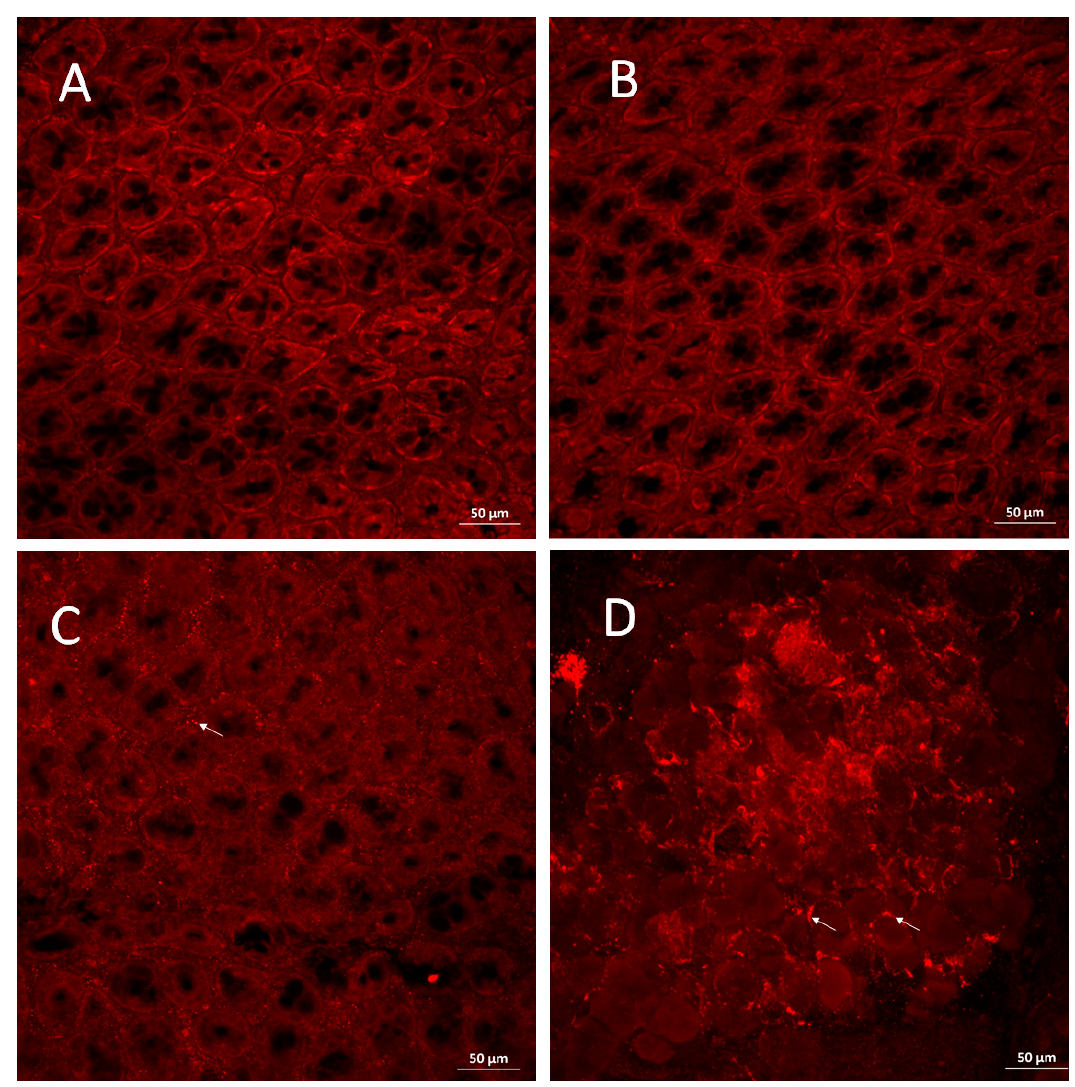
Figure 6. Immunostaining of colonic mucosa. Crypts in ( A ) CTRL and ( B ) DSS3 group show no sign of damage and no expression of PAD4. ( C ) colonic mucosa in DSS5 group is damaged and with peptidyl arginine deiminase (PAD)4-specific signal at the crypt borders. ( D ) colonic mucosa crypts in DSS7 group are disorganized and with strong PAD4-specific signal. Arrows show locations of PAD4-specific signal.